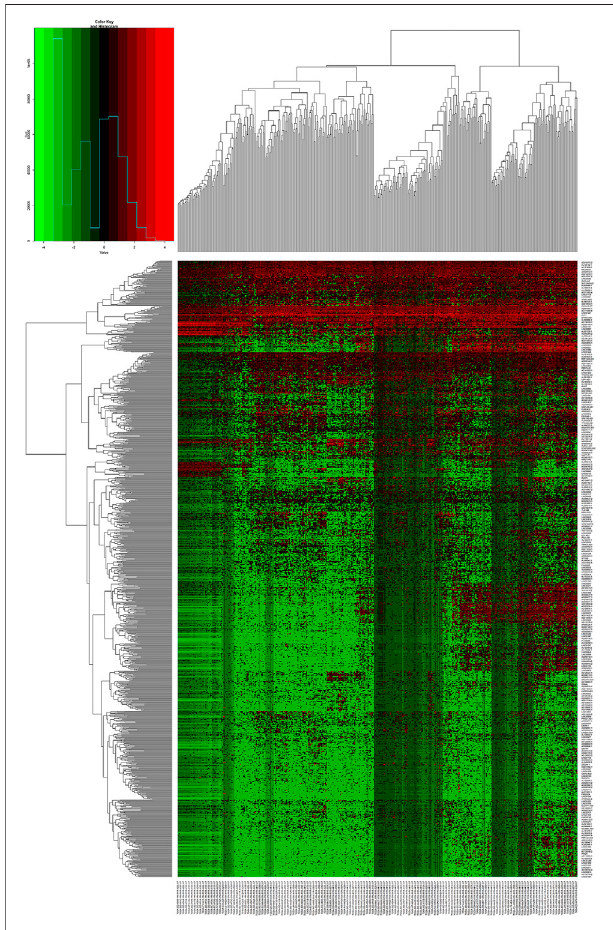
FIGURE 1 | A heat map showing the differential expression of lncRNAs.